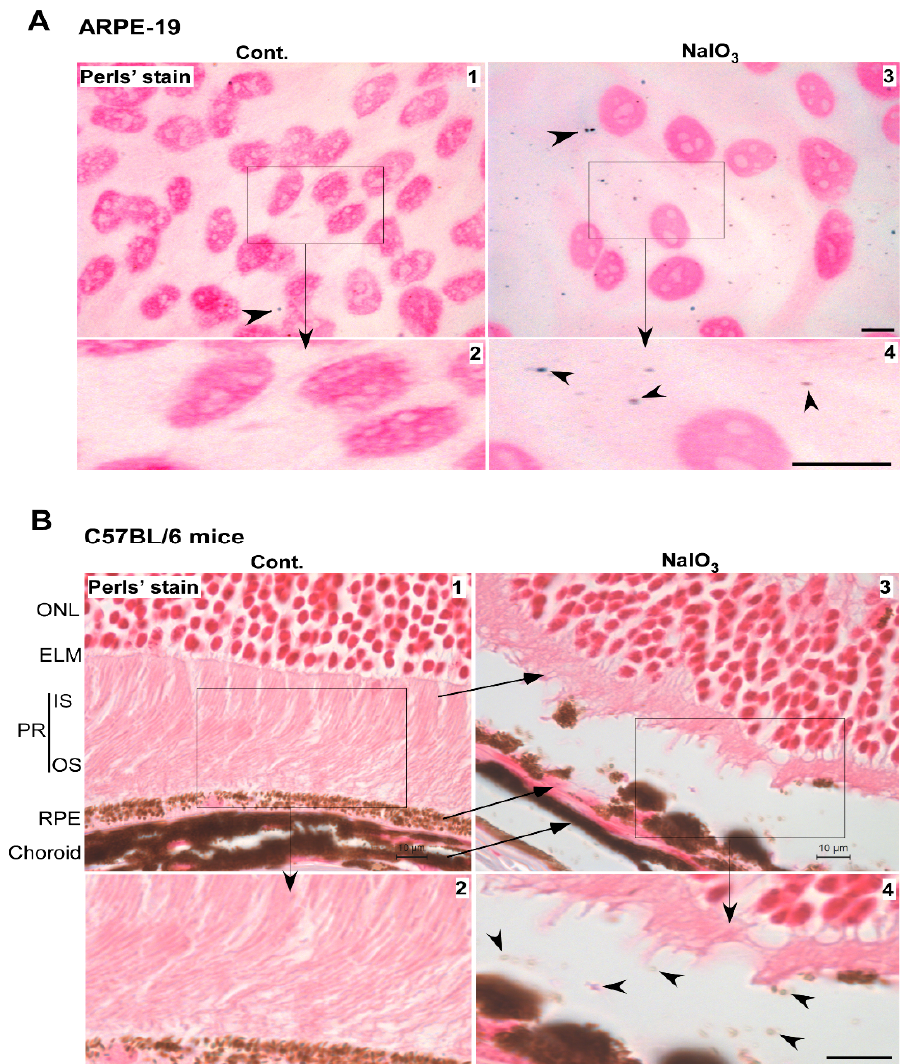
Figure 6. Iron-loaded vesicles are released in the extracellular milieu by NaIO 3 treatment. ( A ) Staining with Perls’ reagent showed several blue dots intracellularly and extracellularly in NaIO 3 -treated ARPE-19 cells (panel 3, arrowhead). Scale bar: 10 µ m. Boxed area is enlarged in panel 4. Scale bar: 10 µ m. A rare blue dot was also noted in control cells (panel 1, arrowhead). Boxed area is enlarged in panel 2. Scale bar: 10 µ m. ( B ) Perls’ reaction of retinal sections from NaIO 3 -treated mice showed a positive reaction in the space between RPE and PR cells (panel 3, arrowhead), better visualized in the enlarged boxed area (panel 4, arrowheads). Scale bar for panel 3: 10 µ m. Scale bar for panel 4: 10 µ m. RPE: retinal pigment epithelium; PR: photoreceptors; OS: outer segment of photoreceptors; IS: inner segment of photoreceptors; ELM: external limiting membrane; ONL: outer nuclear